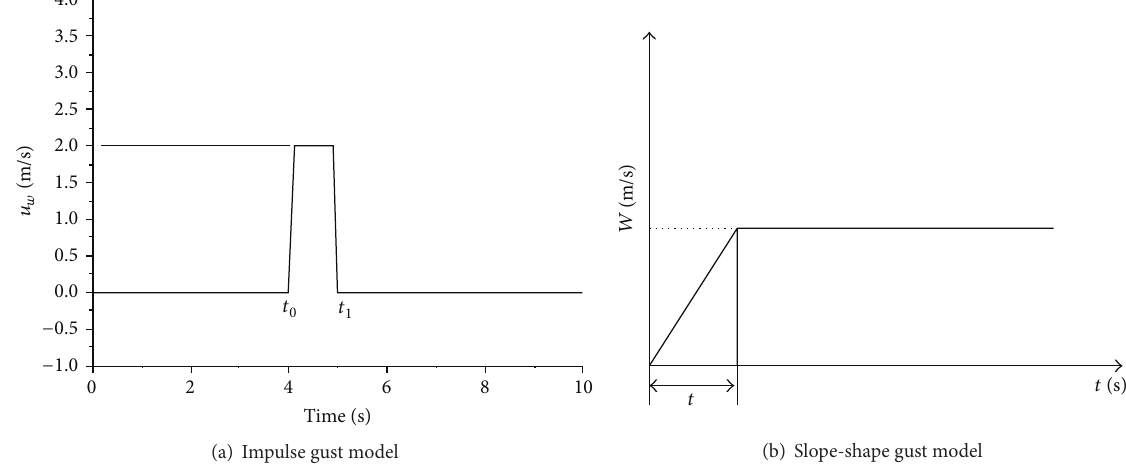
Figure 3: Impulse gust and slope-shape gust